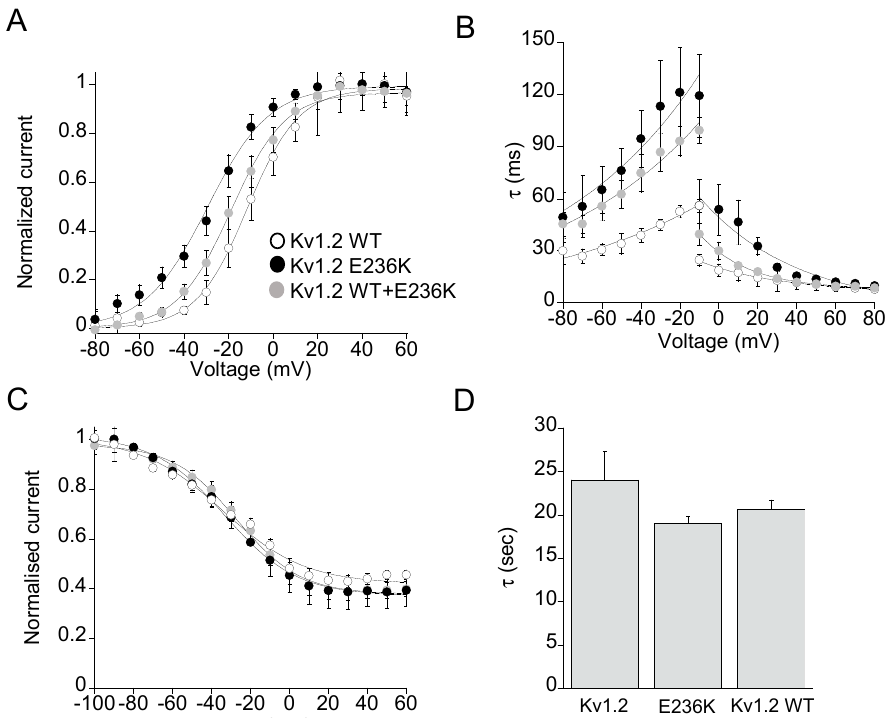
Figure 4. ( A ) The current–voltage relationships for Kv1.2 WT, E236K, and Kv1.2 WT+E236K channels were obtained by plotting the normalized peak tail currents measured at − 20 mV as a function of the prepulse potentials and fitting data points with a Boltzmann function ( n = 10–18 cells). ( B ) Deactivation and activation kinetics measured for Kv1.2 WT, E236K, and Kv1.2 WT+E236K channels. The time constants, resulting from the fit of the activating and deactivating current traces with a single exponential function, were plotted as a function of voltage ( n = 10–19 cells). ( C ) The voltage- dependence of steady-state inactivation for Kv1.2 WT, E236K, and Kv1.2 WT+E236K channels was obtained by plotting the normalized peak currents measured at +40 mV as a function of the prepulse potentials and fitting data points with a Boltzmann function ( n = 7–13 cells). ( D ) Bar graphs showing the time constants of the C-type inactivation for the indicated channels calculated by fitting current decay with a single exponential function ( n = 9–11 cells).